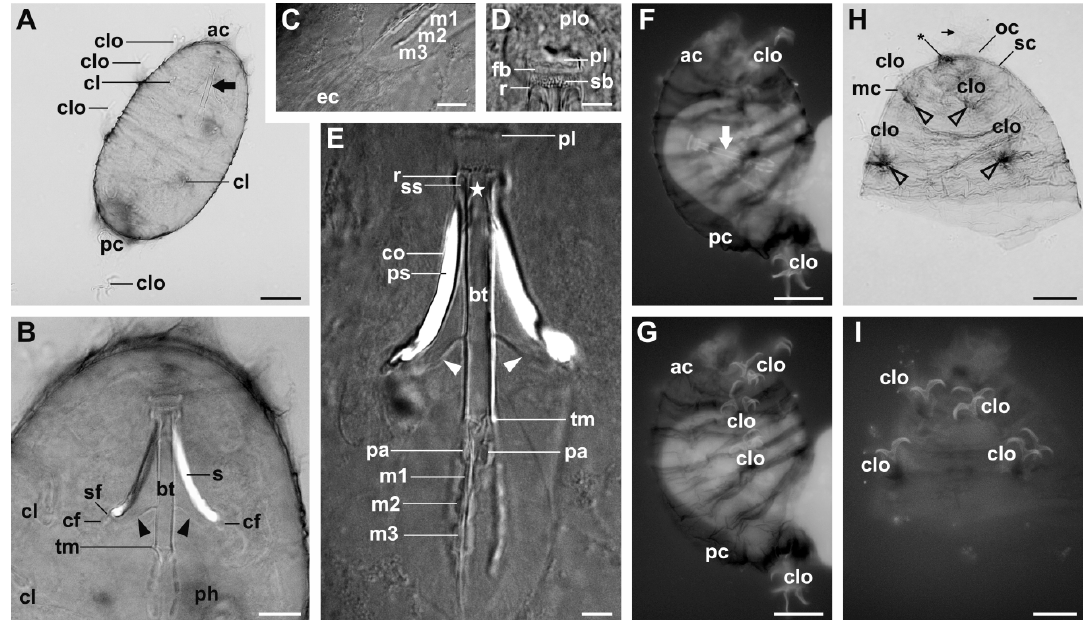
Figure 6. The buccal-pharyngeal apparatus and claws of the cyst. ( A–E ) The buccal-pharyngeal apparatus of the encysted animal, DIC; ( A ) cyst in toto; ( B ) an enlarged anterior part of the cyst (from A) with the buccal-pharyngeal apparatus. Note that only one buccal-pharyngeal apparatus is visible; ( C ) posterior part of the buccal-pharyngeal apparatus with cuticular lining of the esophagus, cyst dissection; ( D ) peribuccal structures and an anterior part of the buccal-pharyngeal apparatus, cyst dissection; ( E ) details of the feeding apparatus, cyst dissection; ( F – I ) cuticular structures; ( F,G ) excystment; ( F ) autofluorescence of the animal’s buccal-pharyngeal apparatus; ( G ) autofluorescence of the cuticular capsule’s claws; ( H , I ) isolated anterior part of the cuticular capsule, cyst dissection; ( H ) cuticles and claws of the cuticular capsule, DIC; ( I ) autofluorescence of the cuticular structures. Scale bars 30 µ m in A,F,G, 10 µ m in B,C, 5 µ m in D,E, and 20 µ m in H,I. Note that only claws show autofluorescence in the anterior part of the cuticular capsule. No additional buccal-pharyngeal apparatuses are detected between the cuticles of the cuticular capsule. Anterior part of the cyst / cuticular capsule (ac); buccal tube (bt); condyle of the furca (cf); claws of the animal (cl); claws of the old cuticle (clo); stylet coat (co); esophagus cuticle (ec); first band of teeth (fb); three macroplacoids in a row (m1,m2,m3); mummy cuticle (mc); old cuticle (oc); pharyngeal apophysis (pa); posterior part of the cyst / cuticular capsule (pc); pharynx (ph); peribuccal lamellae (pl); peribuccal lobes (plo); piercing stylet (ps); rod-shaped thickening (r); stylet (s); second band of teeth (sb); sarcophagus cuticle (sc); stylet furca (sf); stylet sheath (ss); buccal tube margin (tm); putative modified mouth part of the sarcophagus cuticle (asterisk); cuticular legs of the sarcophagus cuticle (empty arrowhead); stylet support (filled arrowhead); buccal crown (star); buccal-pharyngeal apparatus of the encysted animal (thick filled arrow); closed mouth opening of the old cuticle (thin arrow).